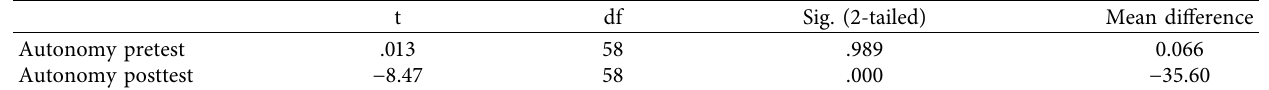
Table 9: Independent-sample test:a T -test for equality of means.